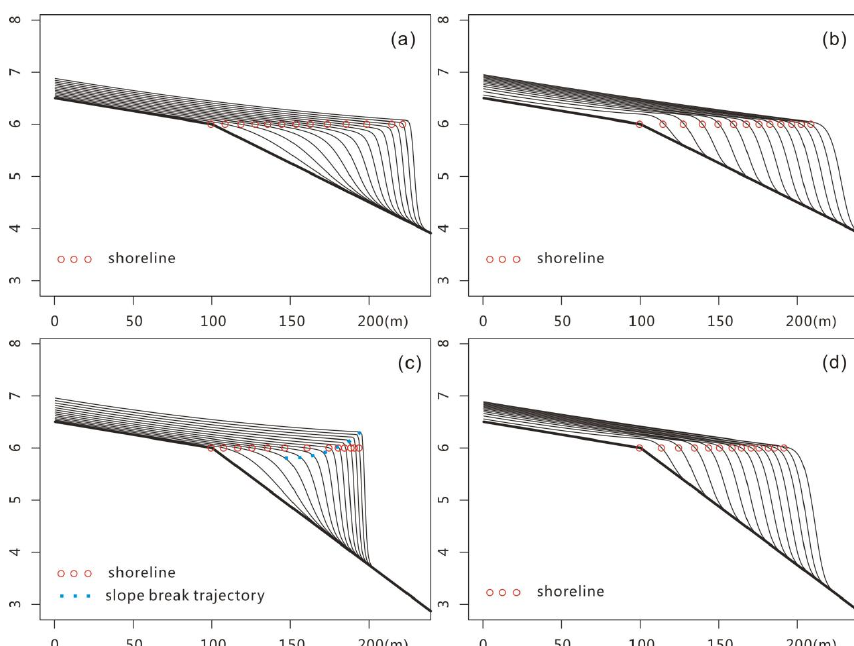
Figure 12. Comparison of the simulated results from a water-depth-based algorithm and the algorithm of Sedapp: (a) clinoforms of gentle slopes created in water depth models, (b) clinoforms of gentles slope created in Sedapp, (c) clinoforms of steep slopes created in water depth models and (d) clinoforms of steep slopes created in Sedapp. The results of the two algorithms did not diverge strongly when the original slope was gentle, while the clinoform shapes and slope break trajectories could be very different when the slope was